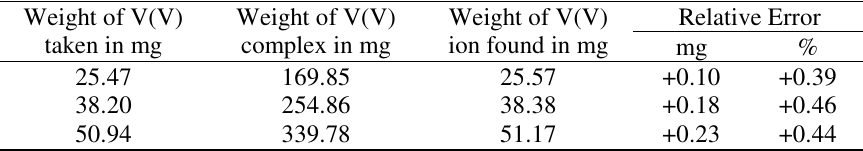
Table 1 . Result of gravimetric estimation of V(V) at pH 5.0, V(V)-HnPBAO